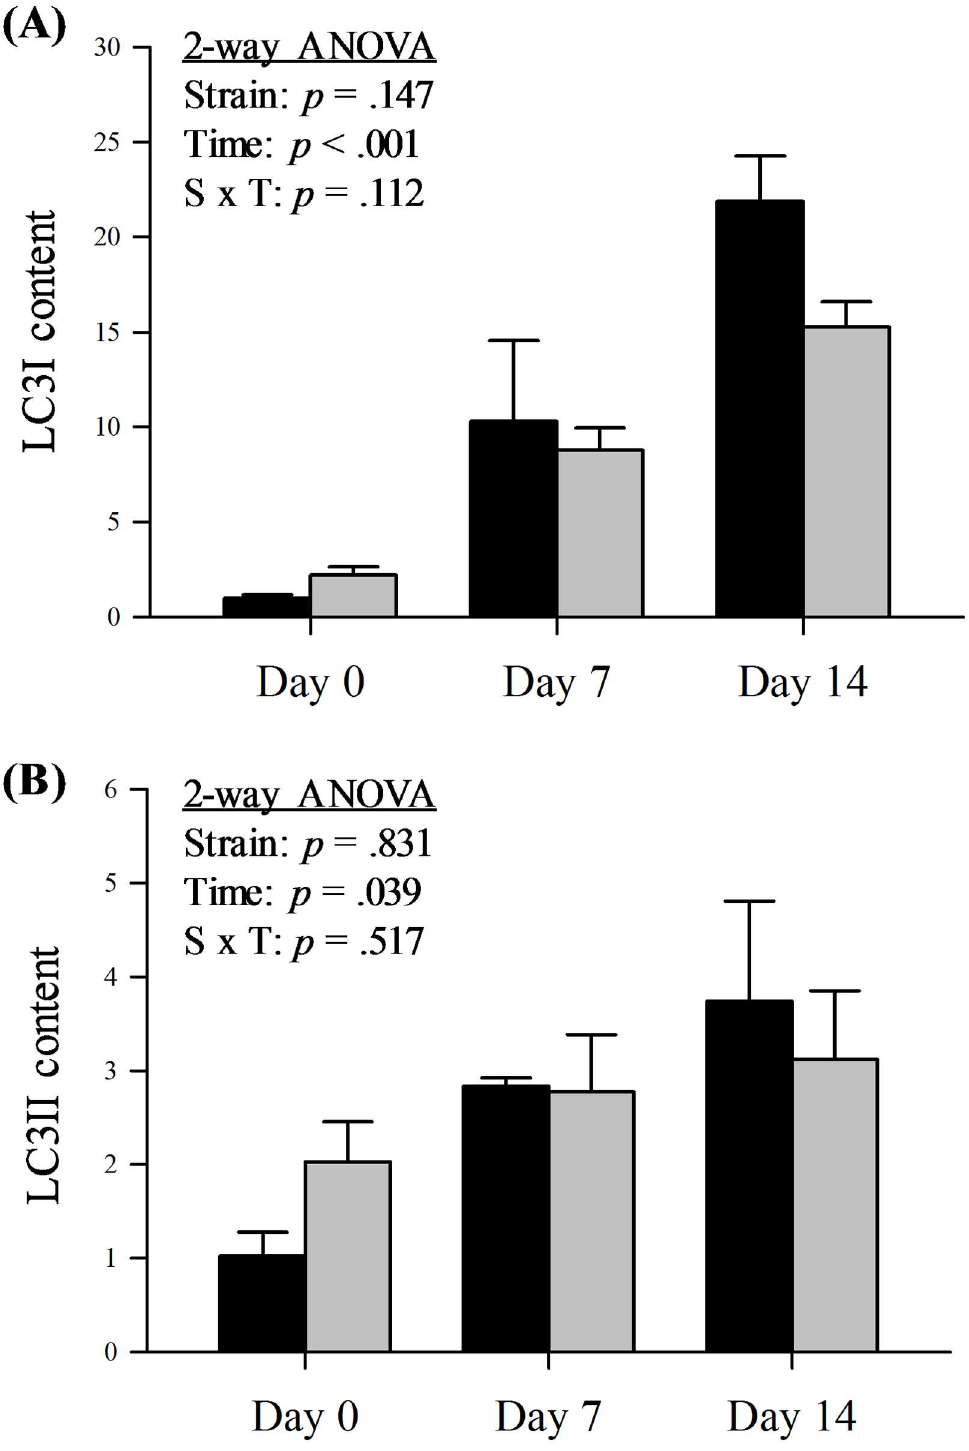
Fig 6. Protein content of autophagy markersLC3 in WT and L7M1 mice with denervation. (A-B) Results of densitometry are presentedas the fold change comparedto WT Day 0 for the autophagy marker LC3. Each panel containsresults of two-way ANOVA that were used to detect the effect of strain (WT vs. L7M1) and time (Day 0, 7, and 14) for (A) LC3I and (B) LC3II (# indicatessignificanteffect of strain/time/S x T interactions, p < .05). Statistical comparisonshoweda significantdenervation (time) effect in both LC3I and LC3II